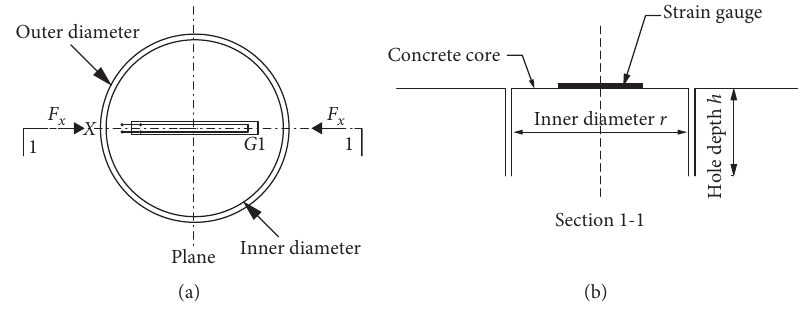
Figure 1: Strain gauge arrangement for uniaxial stress